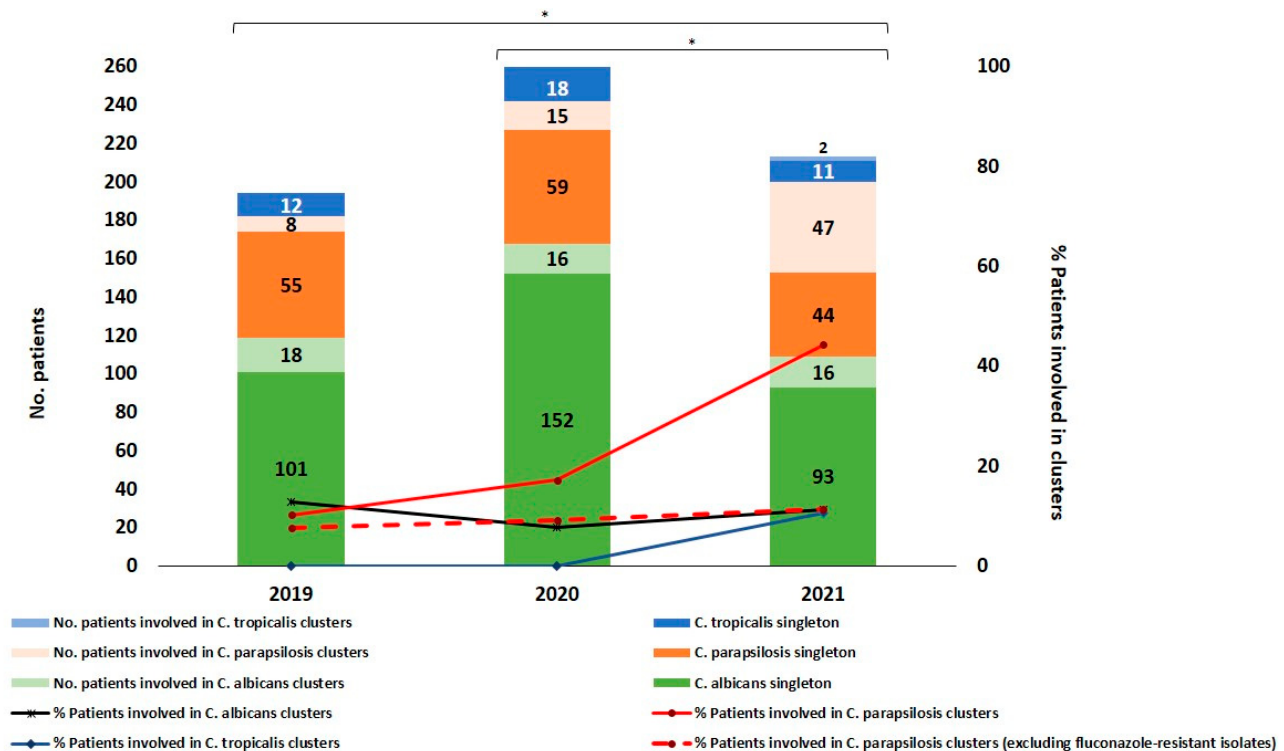
Figure 2. Numbers (and percentage) of patients involved in singleton and intra-hospital clusters per species over the study period. * Differences reaching statistical significance ( p < 0.05).